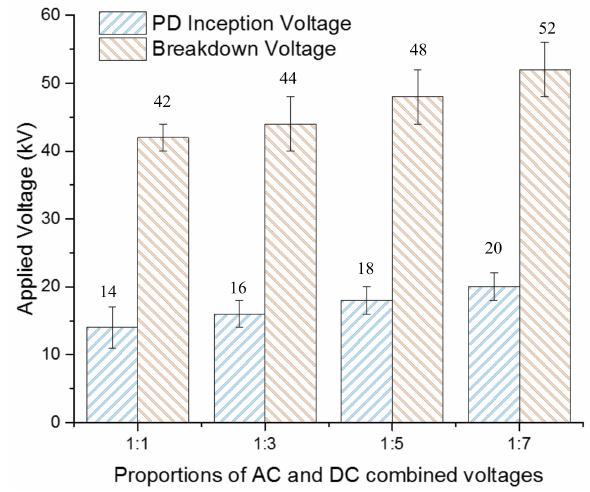
Figure 13. Relationship between PDIV and breakdown voltage and AC/DC